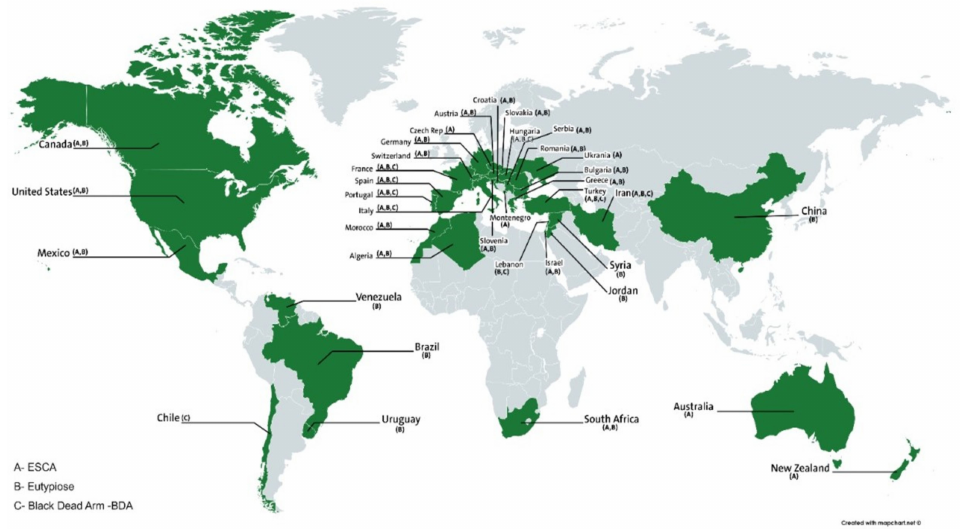
Figure 1. Global distribution of grapevine trunk